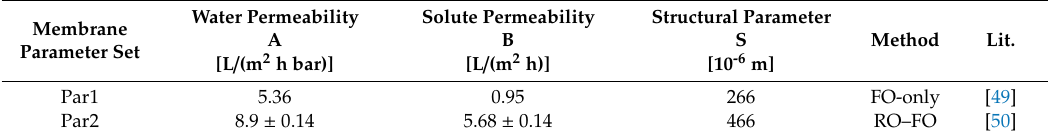
Table 4. Membrane parameters used for